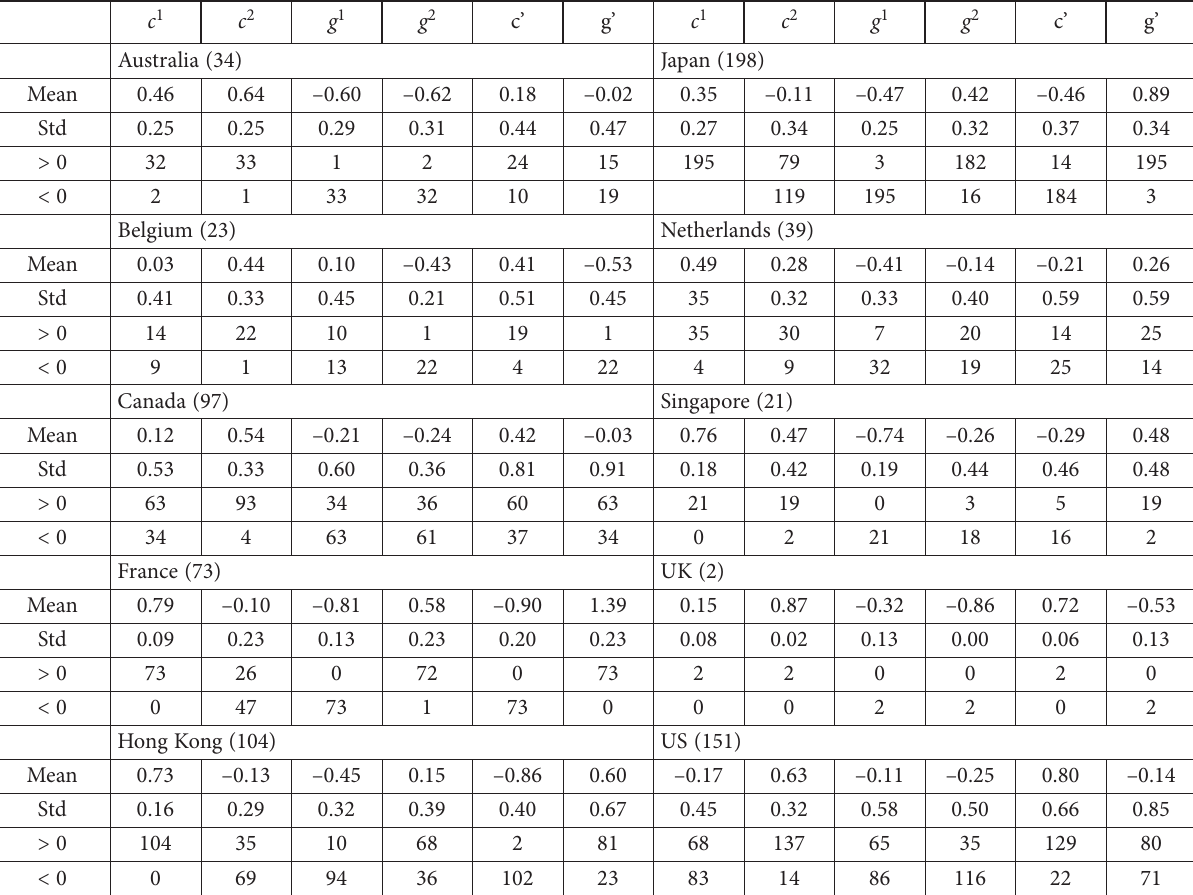
Table 3. Descriptive Statistics of the estimated parameters in asymmetric models for 10 REIT markets (weekly